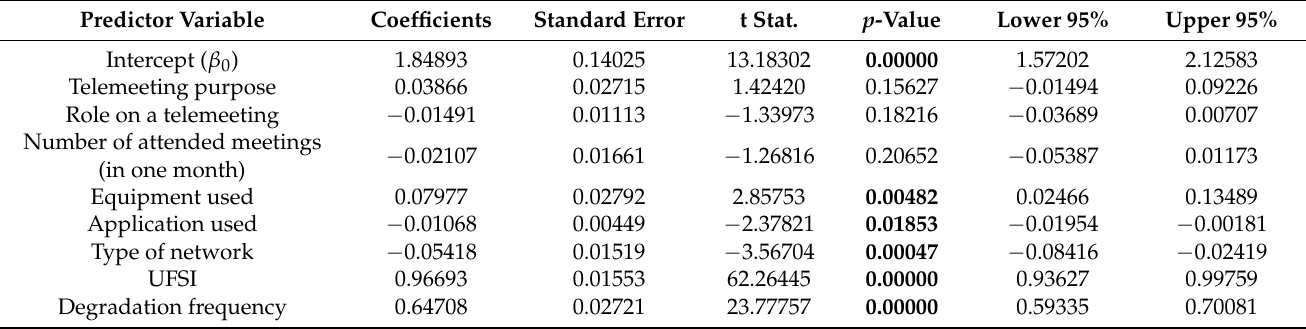
Table 14. Regression coefficients analysis for I get disconnected